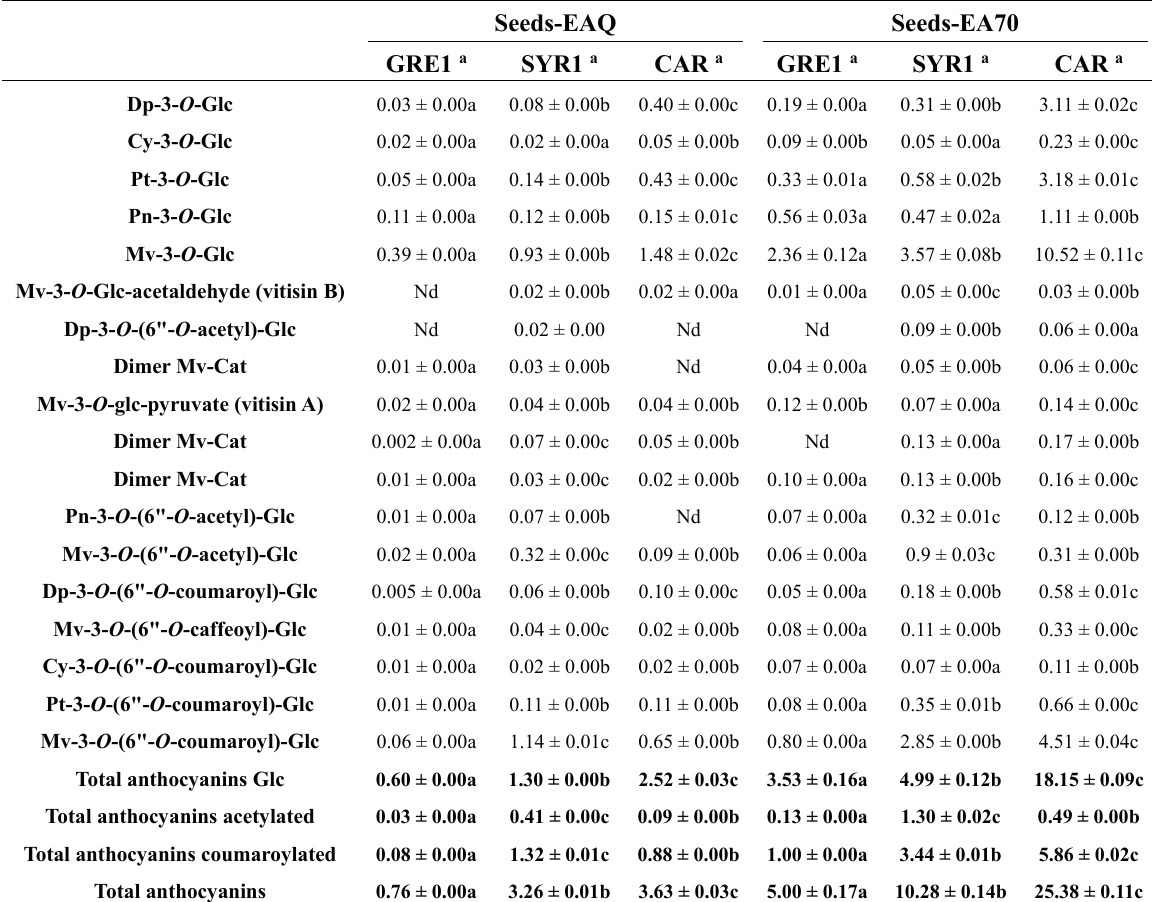
Table 3. Anthocyanin characterisation in EAQ and EA70 grape pomace seed